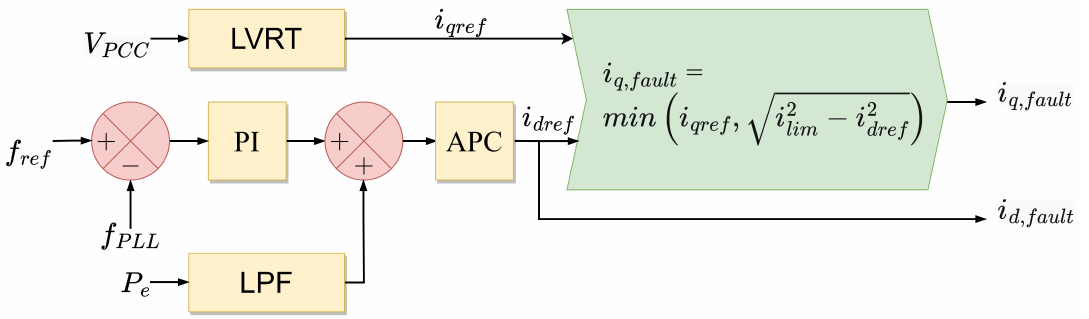
Figure 12. EAC damping provision and revocation of accelerating and decelerating areas